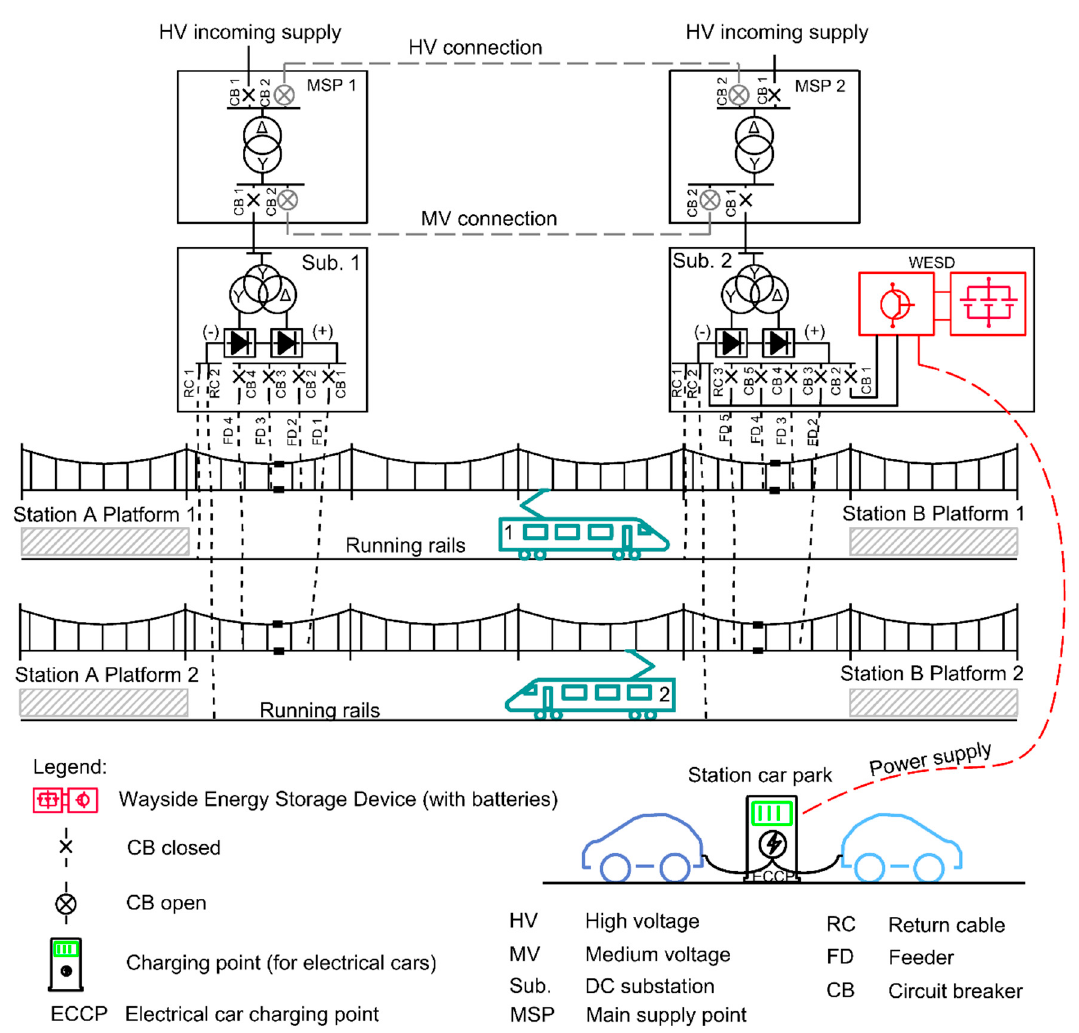
Figure 14. Feeding arrangement with charging point and WESD.